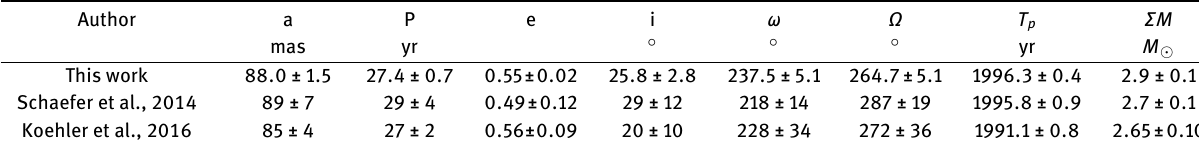
Table 3. The star T Tauri. The orbits of the inner pair S a − S b .